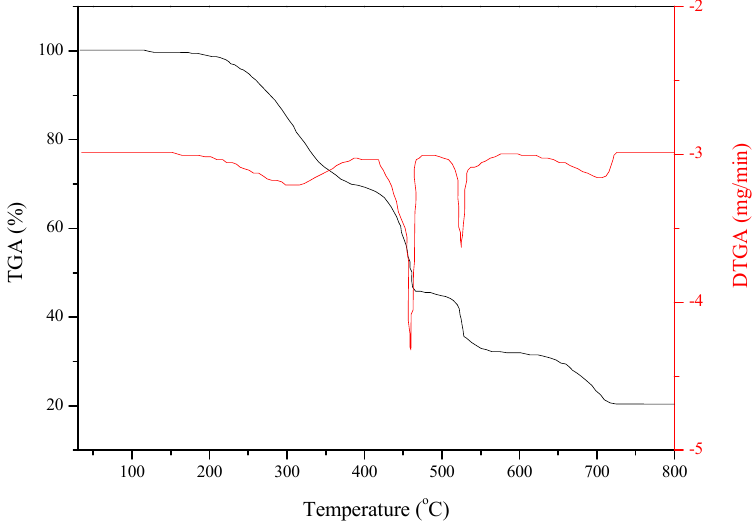
Figure 2. Thermogravimetric analysis (TGA) and derivative thermogravimetry (DTG) curves of the EPDM-r. Table 2. Partial composition of the EPDM-r determined by TGA analysis.